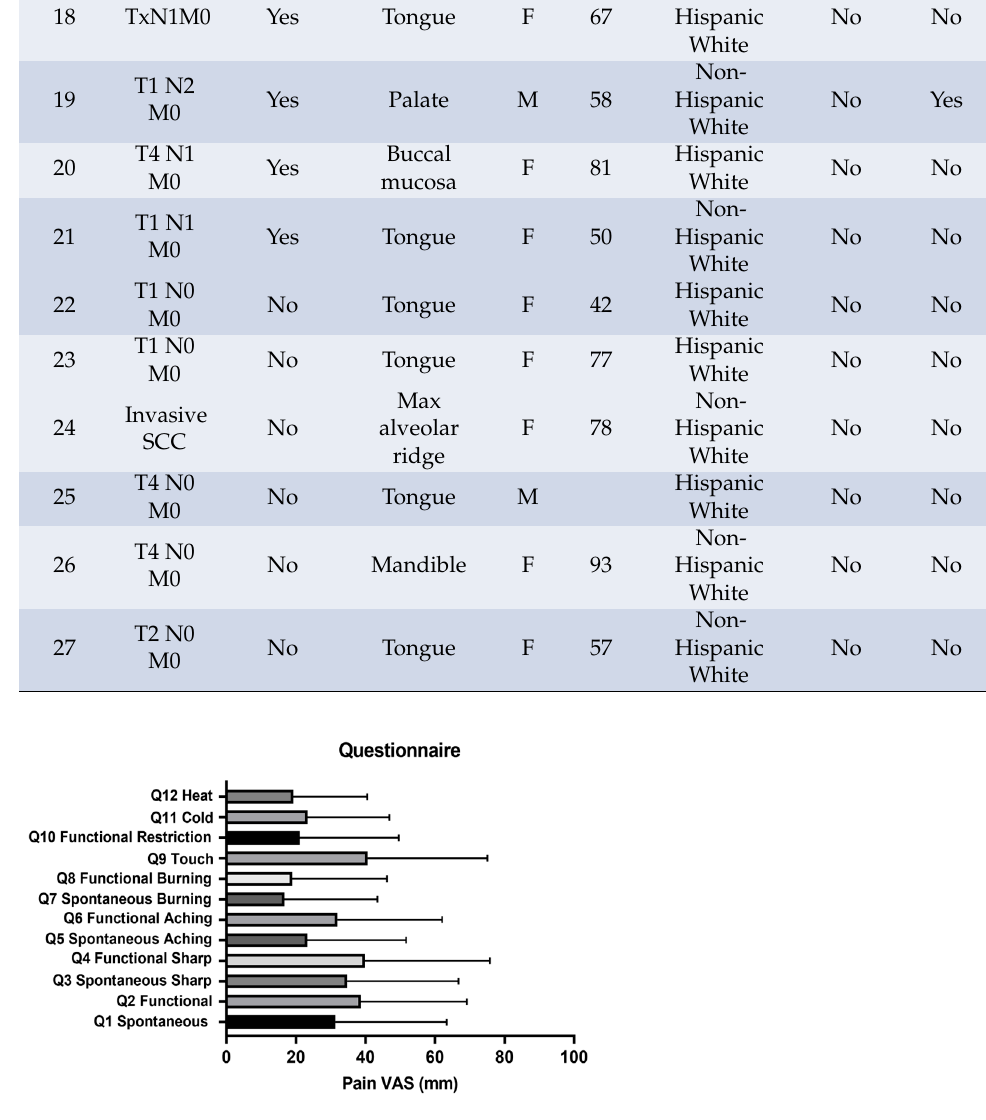
Figure 2. Extended UCSF Oral Cancer Pain Questionnaire. Mean visual analog scale (VAS) pain scores with standard deviation for each of the 12 questions (Q) in the questionnaire.